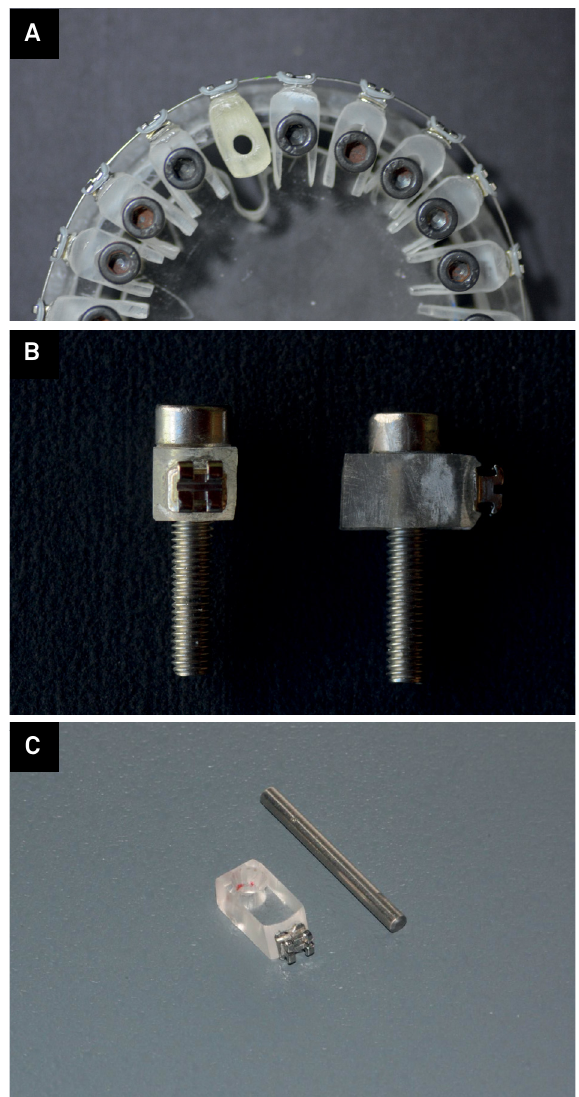
maxillary teeth. (B) Blocks fixed by screws in the resin plate. (C) Block representing the maxillary right central incisor and the metal cylinder used as